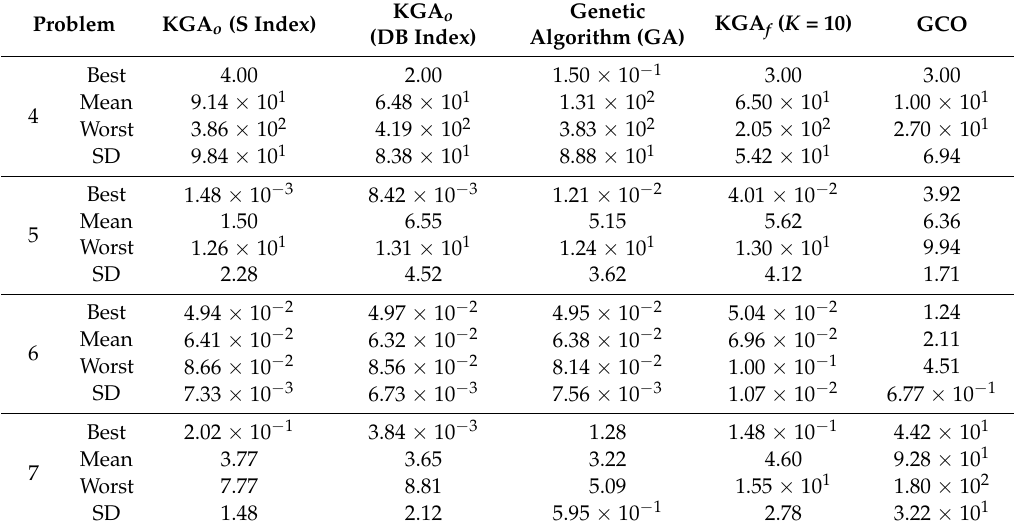
Table 3. Comparison of statistical results of four algorithms for test problems 1–7 of dimensions D = 20.